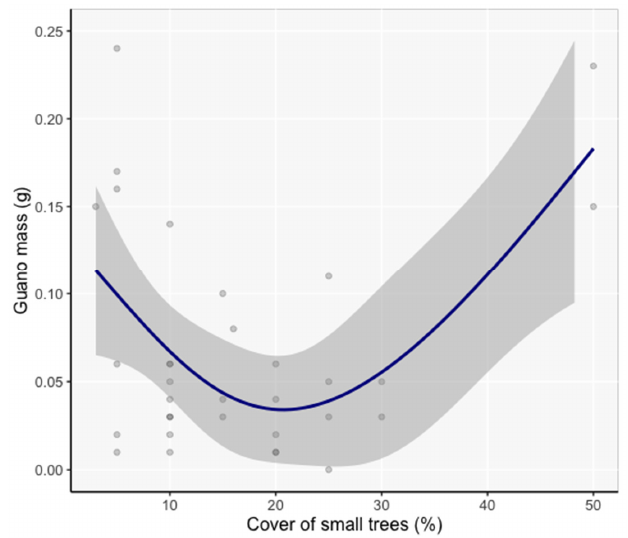
Figure 6. Generalized Additive Mixed Model spline function of guano mass in response to small tree cover (family = Gaussian; link function = identity, n = 36). Shaded areas are 95% confidence intervals.